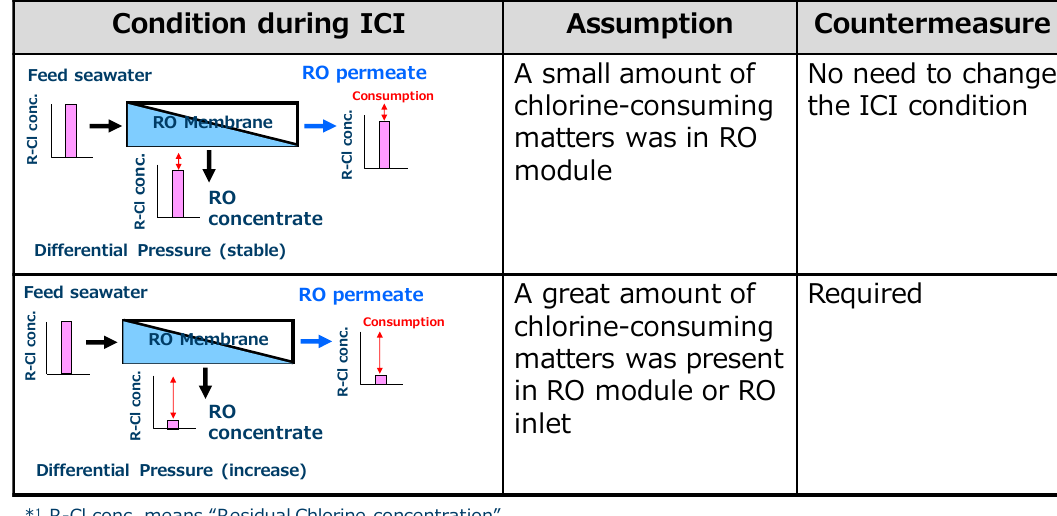
Figure 11. Relationship between intermittent chlorine injection (ICI) condition and chlorine consumption inside the RO module [89].